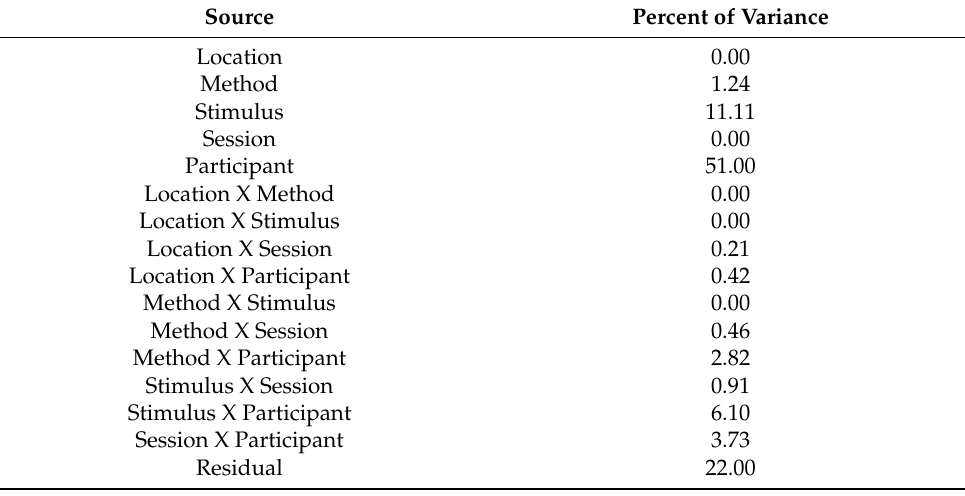
Table 2. Results of variance decomposition of hedonically optimal concentration.